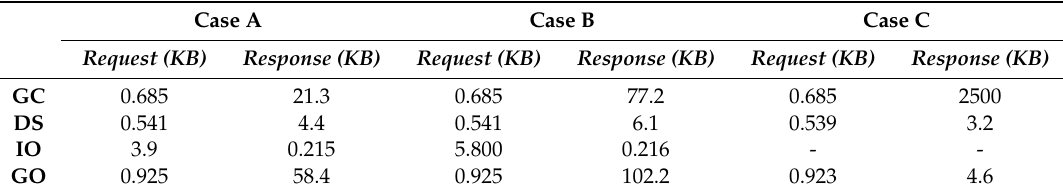
Table 4. Size of requests and responses in KB for di ff erent tasting case and SOS